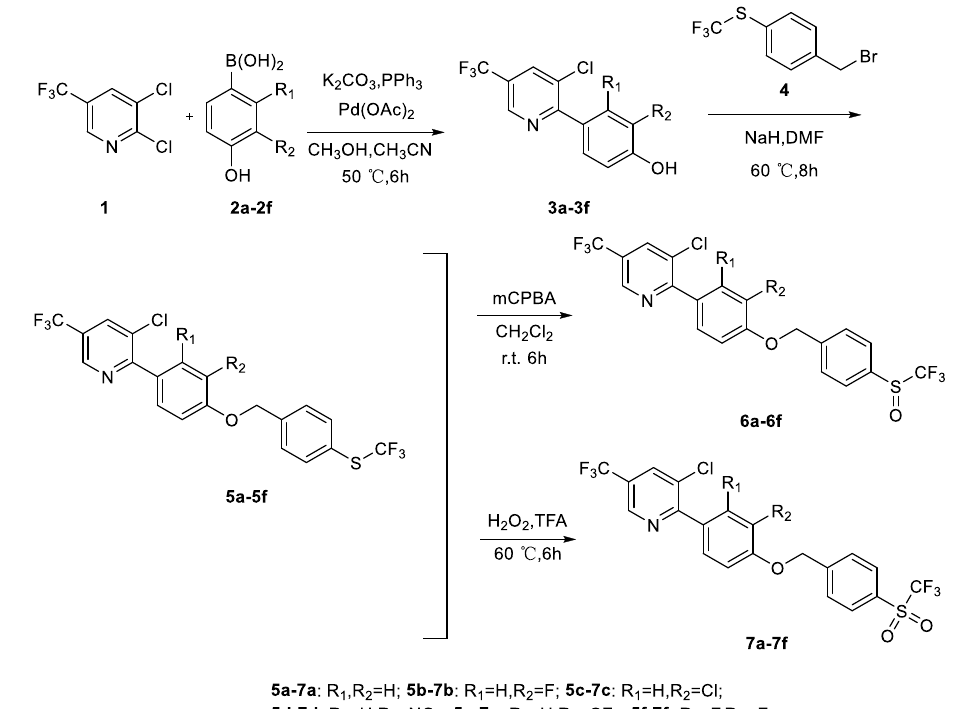
Scheme 1. Overview synthesis methods of α -trifluorothioanisole derivatives.